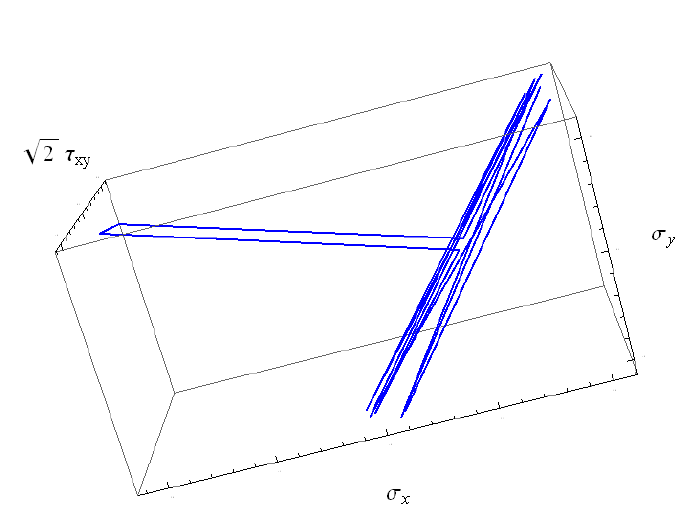
Figure 1: A nearly proportional time-dependent tensor path (plane stress): , , 0  m m d . 1 2